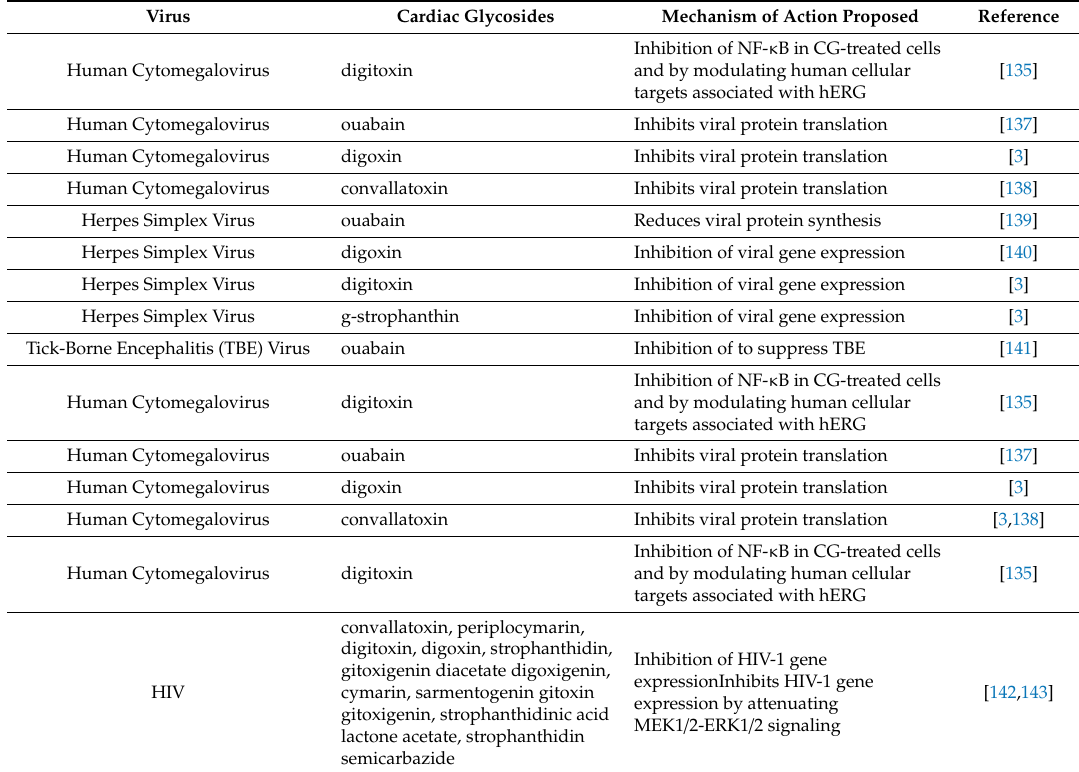
Table 2. Cardiac glycosides with antiviral